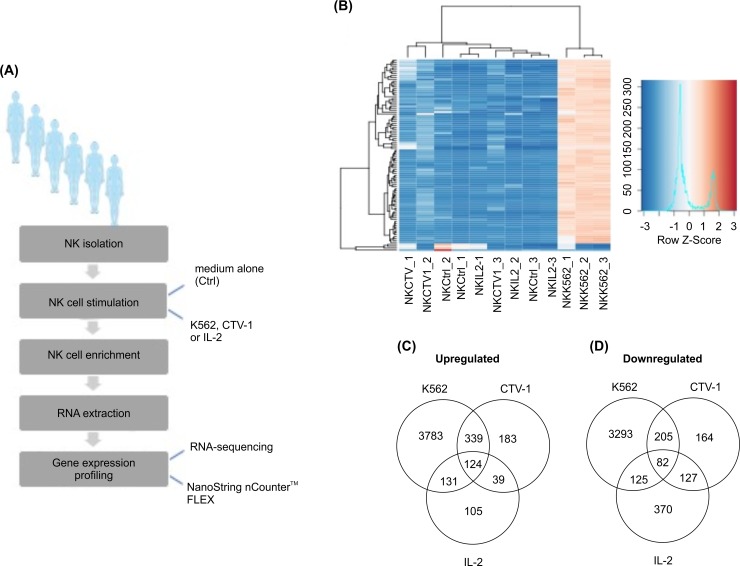
Differential influence of tumor cell or cytokine priming on the transcriptome of NK cells.(A) Schematic of the workflow in obtaining NK cell gene expression profiles after tumor cell or cytokine priming. Human NK cells were isolated from peripheral blood and incubated in medium alone, mitomycin-C-treated K562, or CTV-1 for 6 h or with IL-2 overnight. NK cells were enriched from co-cultures, and RNA extraction and gene expression profiling were performed using RNA-Seq or the NanoString nCounter FLEX platform. (B) Hierarchical clustering was applied to the gene expression values, and the top differentially expressed genes are shown in a heat map with rows representing the relative expression of each gene across 12 samples. Red corresponds to higher gene expression, and blue corresponds to lower gene expression. Similarity in gene expression patterns between different samples are reflected in the resulting dendrogram. Z-Score is calculated using the following formula: (gene expression value in sample of interest)—(mean expression across all samples) / SD. Venn diagrams generated by the intersection of list of genes upregulated (C) or downregulated (D) by at least 1 Log2fold (P <0.05) vs. NK cells incubated in medium alone are shown.